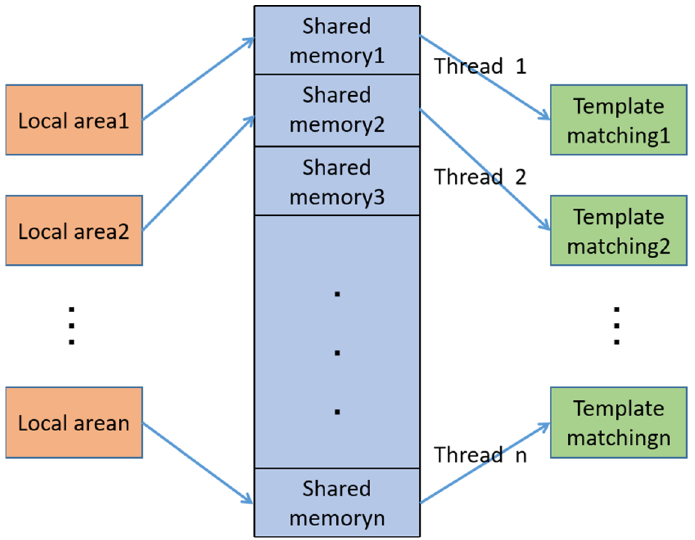
Figure 14. Compensation process for global target detection information.